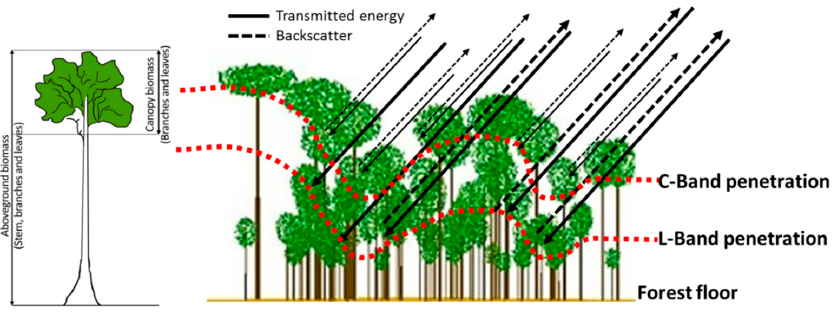
Figure 11. Common interaction of SAR L- and C-bands with the forest structure.